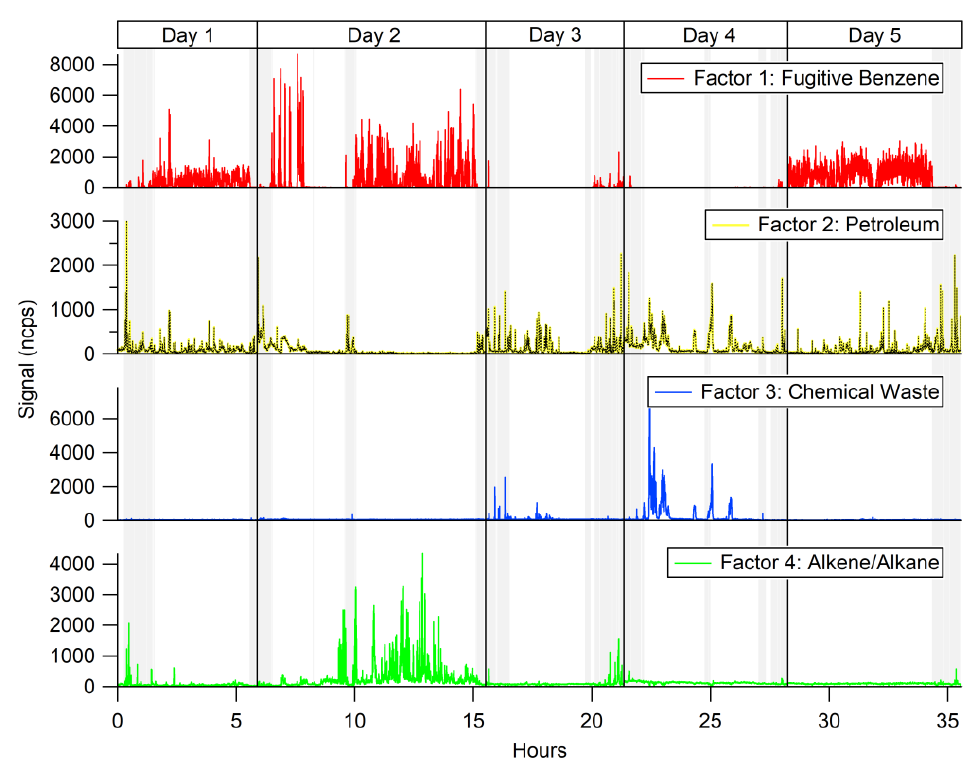
Figure 2. Temporality of factor contributions for the four local factors. Mobile monitoring periods are highlighted in grey and stationary monitoring periods are indicated by a white background.